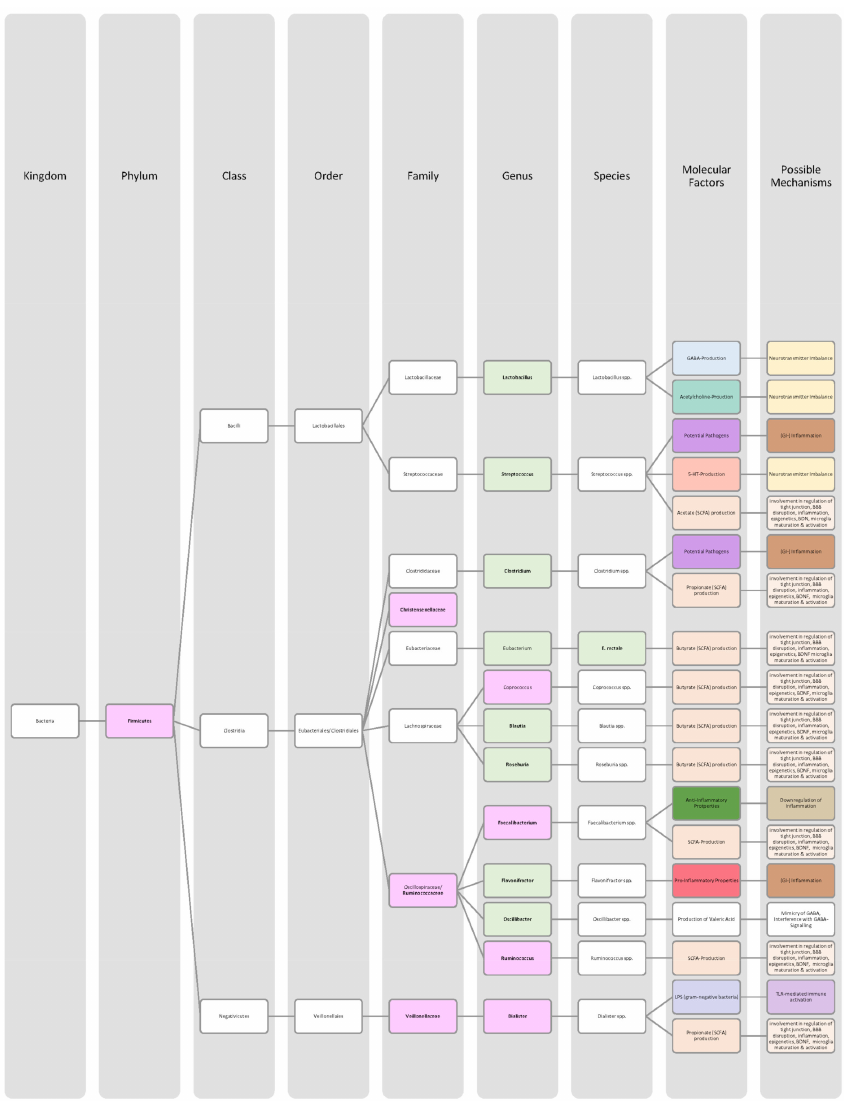
Figure 11. Part 2 of visual representation of the changes in microbiota composition in major depres- sive disorder (MDD) patients from Table 7. For Figures 10 and 11: The pedigree design highlights the taxonomic classification of the dysbiotic bacteria. Light green cells stand for an increase and the light red cells for a decrease, respectively. Significant changes are shown in bold letters ( p < 0.05 or LDA values > 2). White cells indicate that no changes were reported or, in the case of Bifidobacterium, both significant increases and decreases were found. The last two columns contain additional, non- exhaustive information on how the bacteria are thought to impact the pathogenesis. The second last column to the right depicts bacterial molecular factors, which may be components of the bacteria or bacterial metabolites. Finally, the last column lists possible mechanisms by which these molecular fac- tors may interfere with disease development. The colours summarise factors or mechanisms that are repetitive. Bacterial production or involvement in the metabolism of GABA (light blue, [18,20,100]), acetylcholine (emerald colour, [18,20]), phenylalanine (dark orange, [27]), noradrenaline (light yel- low, [18,20]), and 5-HT (salmon colour, [18,20]) may lead to an imbalance in central nervous sys- tem neurotransmitters (yellow). Eggerthella spp. and Flavonifractor spp. have pro-inflammatory properties (red) and are linked to inflammatory conditions present in MDD (brown) [100]. Addi- tionally, Eggerthella spp. are thought to interfere with bile acid signalling pathways because certain strains can facilitate the oxidation of bile acids, which eventually leads to disturbances in BDNF production. BDNF has been found in lower quantities in MDD patients [99]. Some Streptococcus spp.